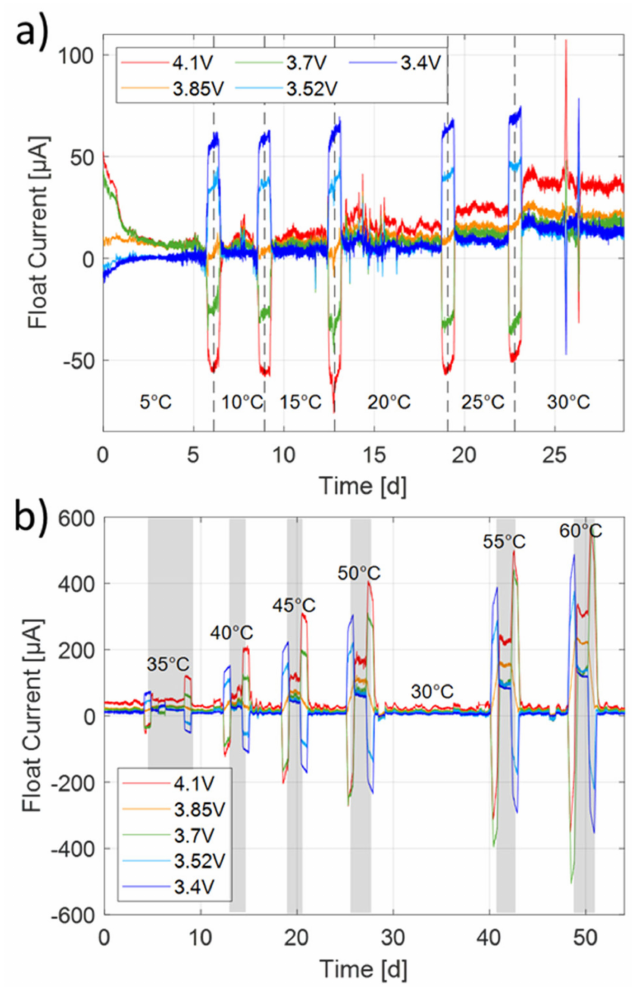
Figure 5. Float current over time for five different test voltages for: ( a ) the low temperature cycle from 5 to 30 ◦ C; and ( b ) the high temperature cycle from 30 to 60 ◦ C. In grey bars, the parts higher than 30 ◦ C are highlighted for better understanding. For a better overview, the first few days including the transient part after the check-up are excluded from the graph (7 days in the low temperature sequence and 14 days in the high temperature